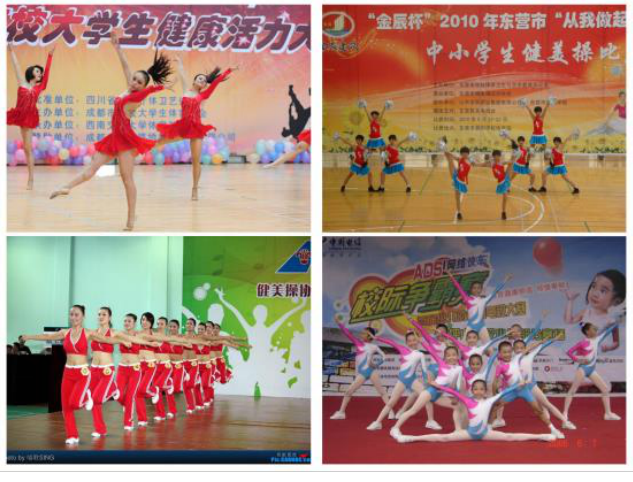
Figure 1: Aerobic